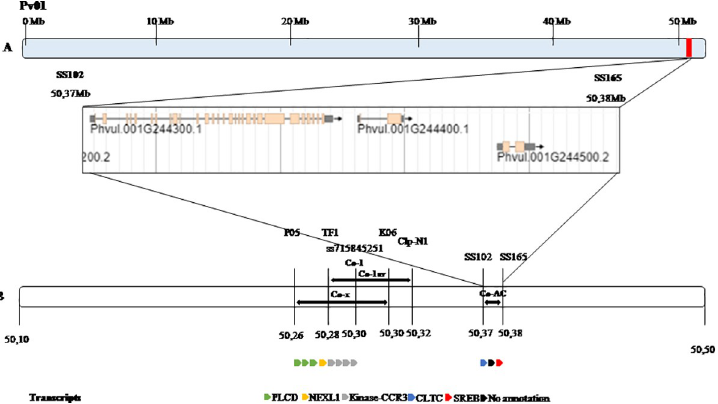
Fig 2. Fine mapped region for Amendoim Cavalo resistance locus Co-AC . Fig 2A. Chromosome Pv01 with Co-AC region highlighted in red at the end of the chromosome. Three predicted genes are within Co-AC region flanked by the markers SS102 and SS165. Fig 2B. Comparison between the physical position (Mb) of the Co-AC locus , Co-x [33], Co-1 , and Co-1 HY [8] and predicted transcripts for each gene region. Color codes represent predicted gene functions. Orange represent phosphatidylinositol phospholipase C, delta (PLCD) protein, purple represent NF-X1 type zinc finger protein (NFXL1), green represent serine/threonine-protein kinase- like protein CCR3-related protein (Kinase-CCR3), blue represent clathrin heavy chain protein (CLTC), red represent sterol regulatory element binding protein (SREB) and black represent protein with unknown function. The genomic region between these markers is indicated by the lower bar and cover around 9,45 Kbp of the genome.